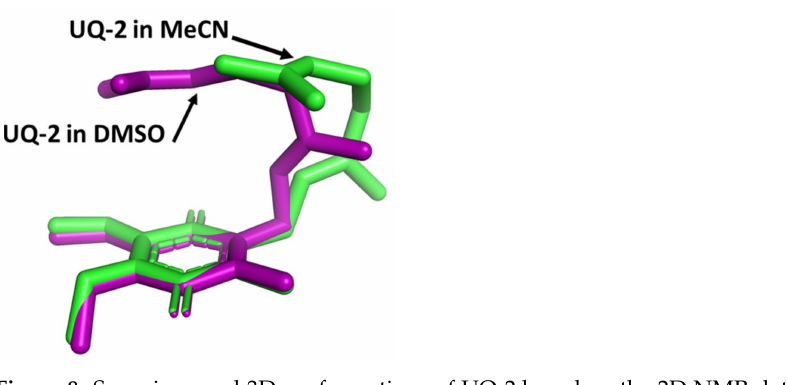
Figure 8. Superimposed 3D conformations of UQ-2 based on the 2D NMR data in d 3 -acetonitrile (MeCN, green) and d6-DMSO (purple). This figure was originally published in Ref. [41] and is licensed under CC-BY 4.0. The original figure included two images however only the depicted image is shown